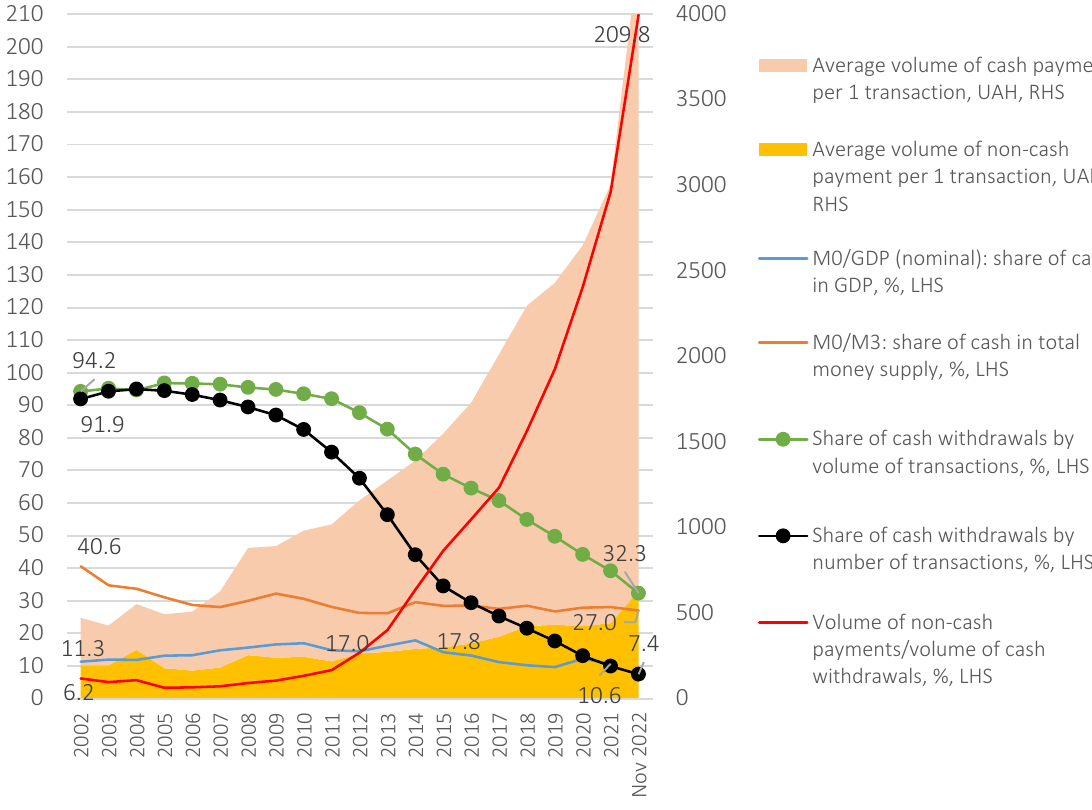
Figure 1. Types of payments in Ukraine, 2000 – November